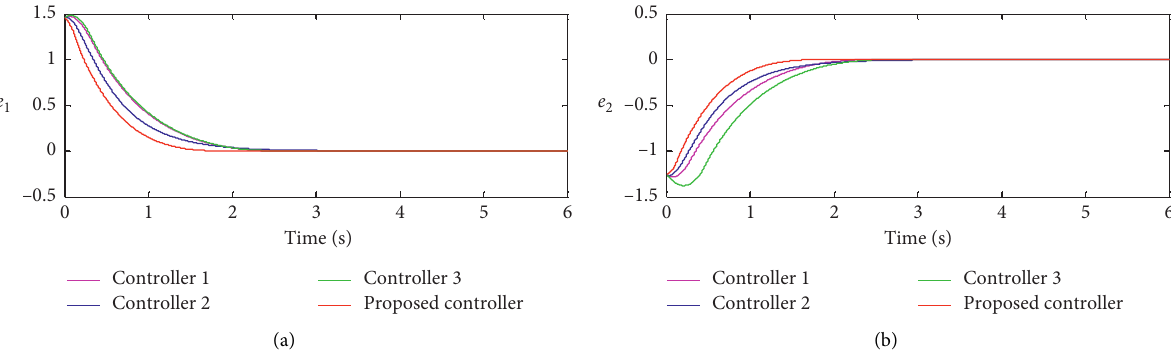
Figure 12: Position tracking errors under four controllers.